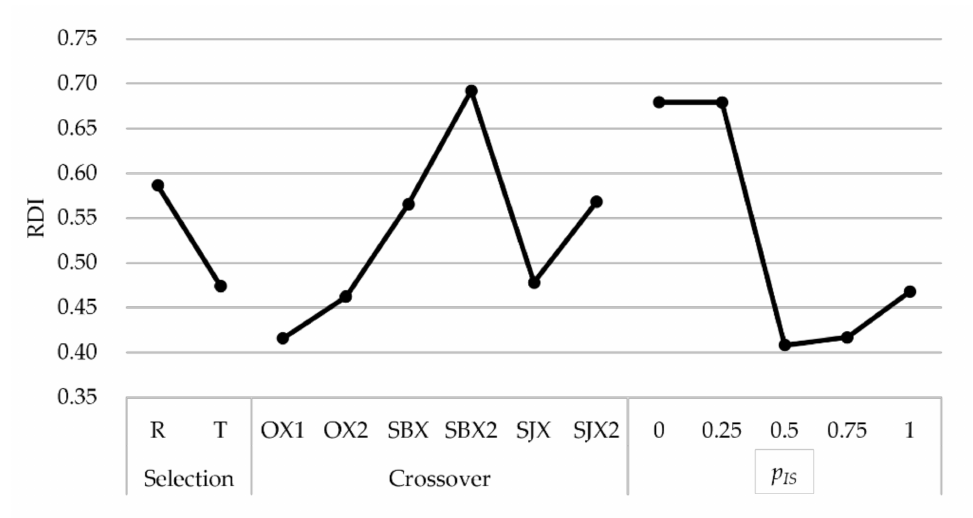
Figure 7. GA calibration for selection, crossover, and mutation.